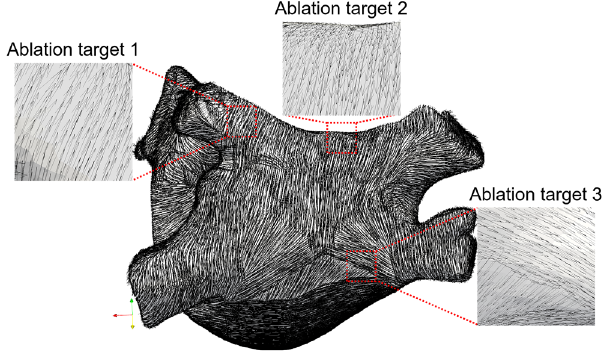
Figure 6. The fiber orientation incorporated into the LA model and the details of the fiber orientation at three ablation targets.